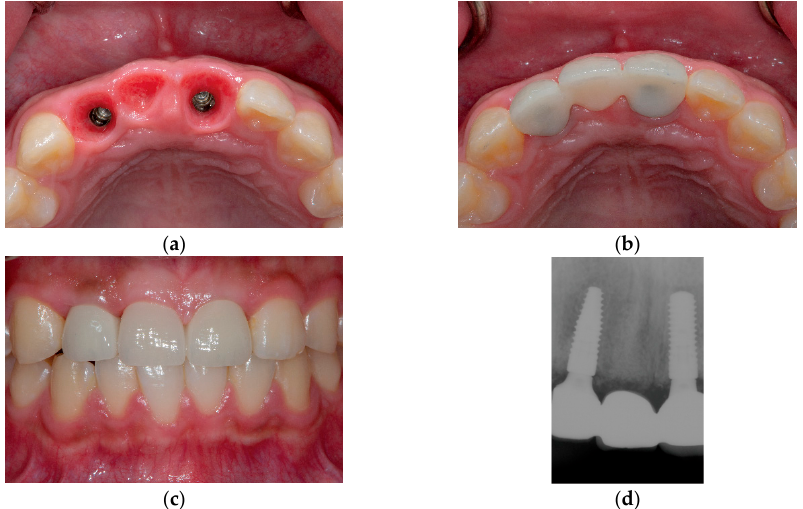
Figure 6. Clinical photographs and a periapical radiograph of the definitive porcelain-veneered zirconia fixed dental prosthesis; ( a ) Occlusal view after removal of the provisional restoration, showing healthy mucosa profiles; ( b ) Occlusal view after placement of the definitive restoration; ( c ) Frontal view after placement of the definitive restoration; ( d ) Periapical radiograph. J. Clin. Med. 2019 , 8 , x FOR PEER REVIEW